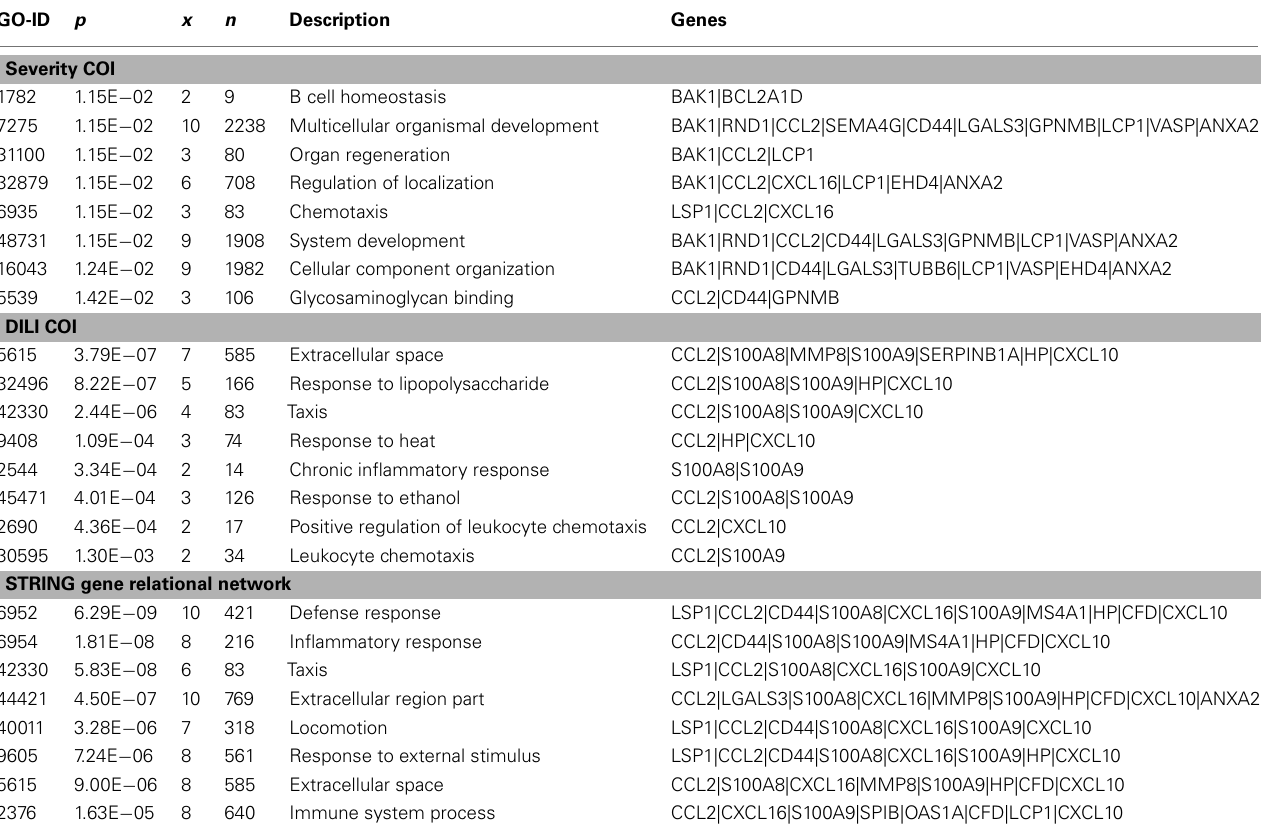
Table 2 |Top eight BiNGO gene ontology terms enriched in Severity and DILI predictive gene signatures, and STRING gene relational network generated from the three predictive